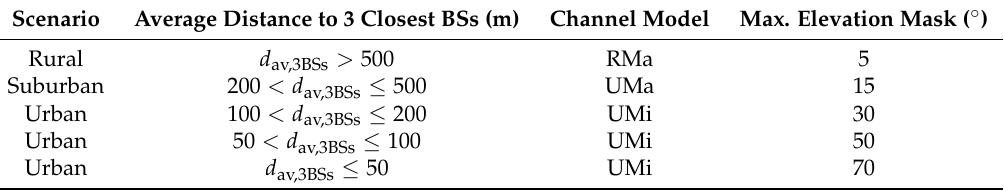
Figure 4. Elevation mask defined by the average distance to the three closest BSs of a representative cellular network deployment. Table 2. Hybrid scenario definition based on cellular network density and GNSS elevation